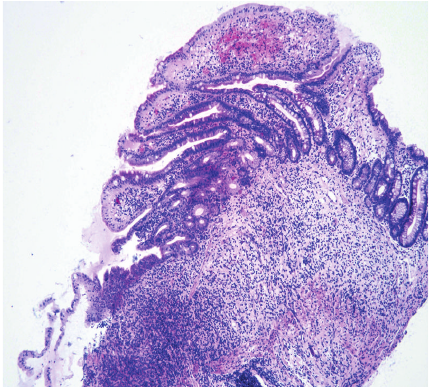
Figure 3: Increased content of collagen was found in interstitial tissue of the small bowel. Optical histology, hematoxylin-eosin staining. Original magnification 40x. Courtesy of Vˇera Tyˇcov´a,